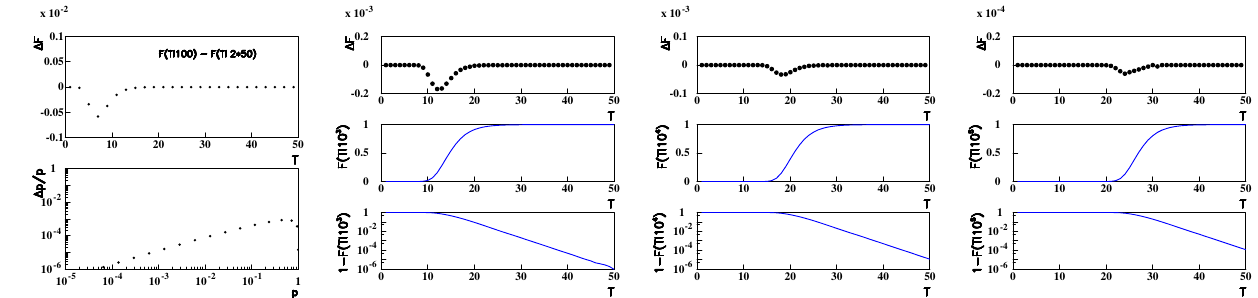
n = 100. Last column: n = 1000. The value of n for the N = 50 case is always twice that used for N = 100 so that L = Nn is the same. The value plotted in the upper plots is F ( T | n · 100 ) − F ( T | 2 n · 50 ) , the second plot shows the cumulative distribution, and the third plot the p = 1 − F value on the log scale